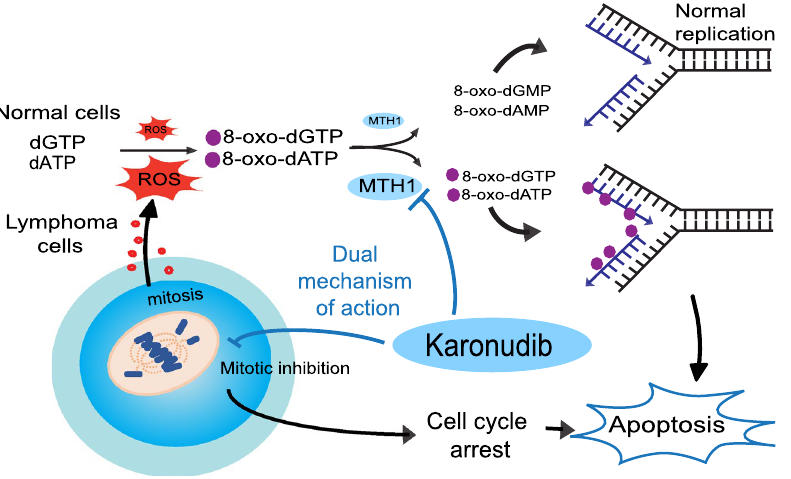
Figure 7. Dual mechanism of karonudib leads to apoptosis in lymphoma cells. Karonudib was developed to target the nucleotide metabolism by inhibiting the nucleotide pool sanitizing enzyme, MTH1. MTH1 converts oxidized nucleotide triphosphates created by reactive oxygen species (ROS) to the corresponding monophosphate forms, preventing incorporation of oxidized nucleotides into DNA. High ROS levels in lymphoma corresponds to high MTH1 levels. Karonudib inhibits the function of MTH1 and results in increased oxidized nucleotides in the DNA, and the drug also perturbs microtubule polymerization and leads to cell cycle arrest and